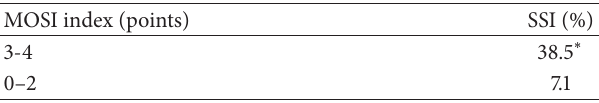
Table 6: Relationship between the incidence of SSI and the muscu- loskeletal oncological surgery invasiveness (MOSI)